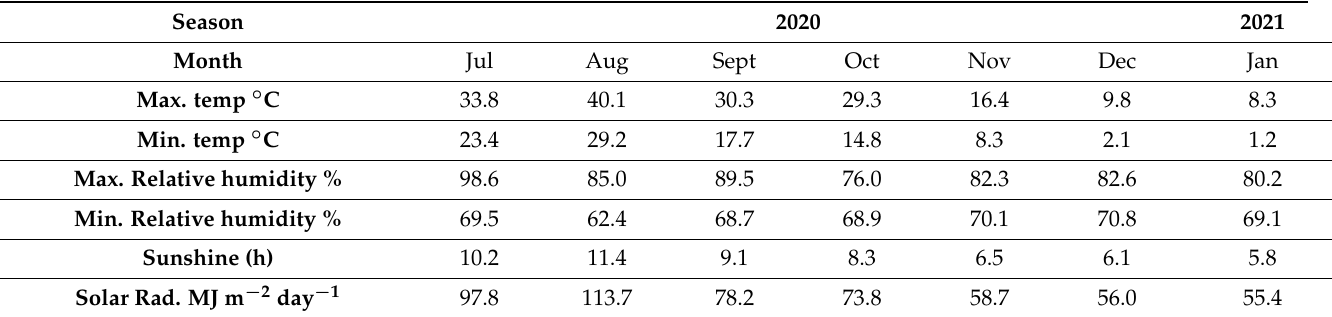
Table 1. Mean monthly climate records during the years of the experiment